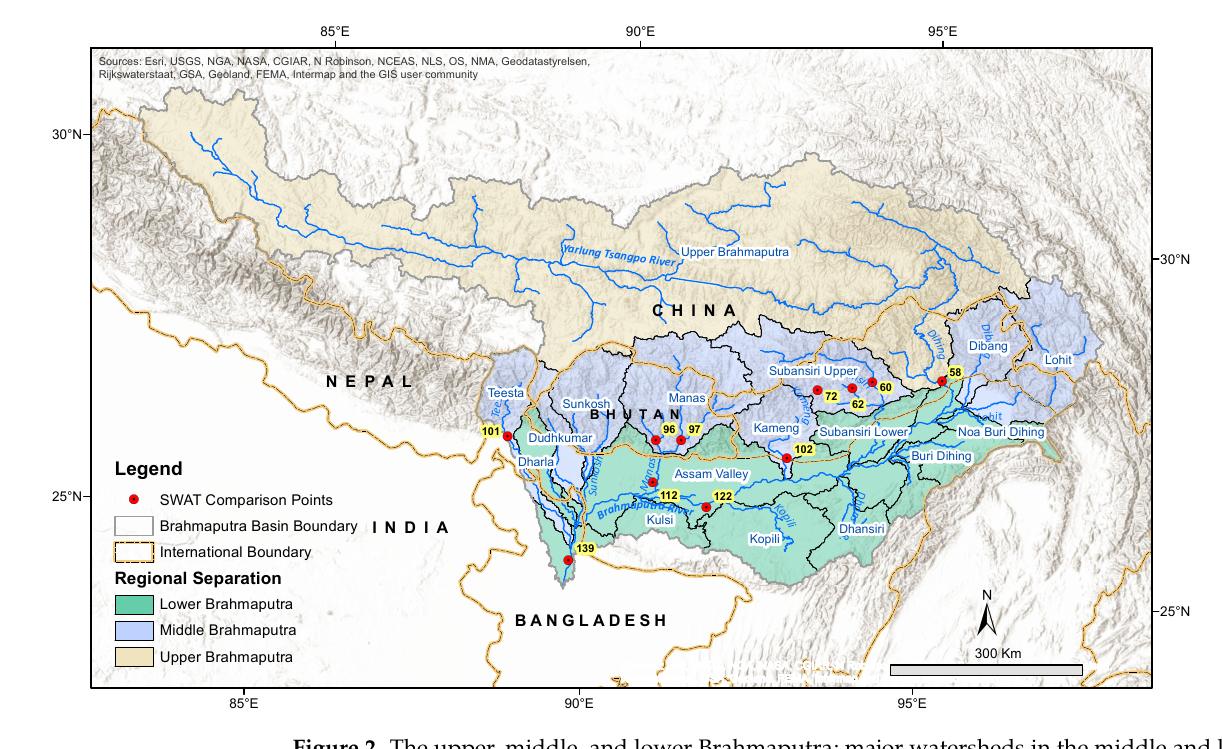
Figure 2. The upper, middle, and lower Brahmaputra; major watersheds in the middle and lower Brahmaputra; and positions of SWAT streamflow comparison points (map source: prepared by the